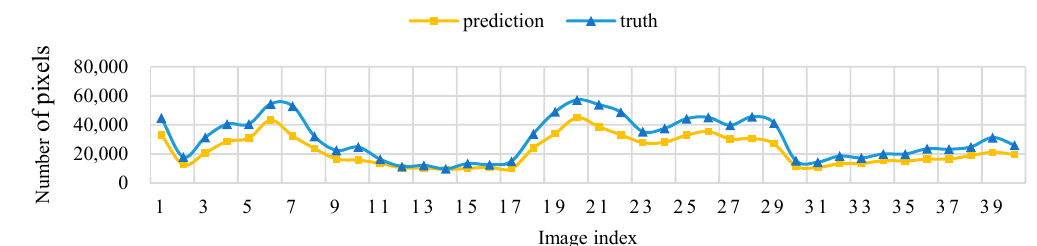
Figure 12. Threshold level T = 5, sampling size S = 70 pixels, test set image true value pixel, and the predicted pixel number change curve.